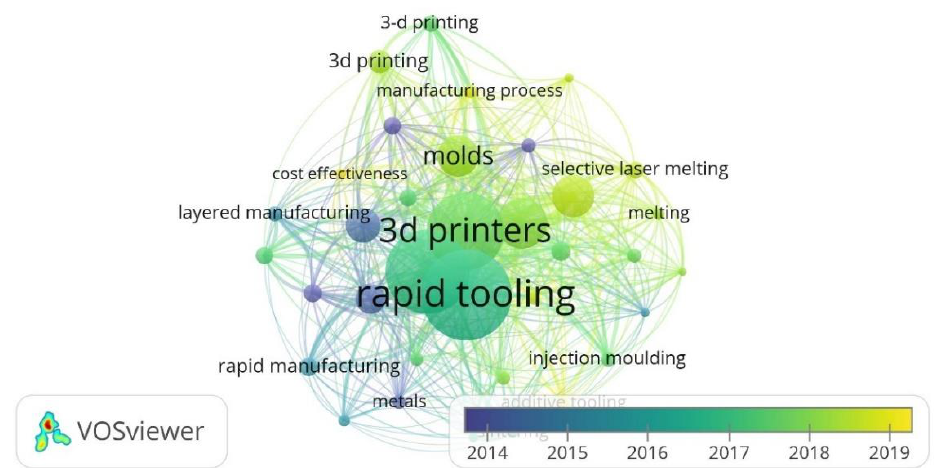
Figure 3. Network of keywords retrieved from the literature search.